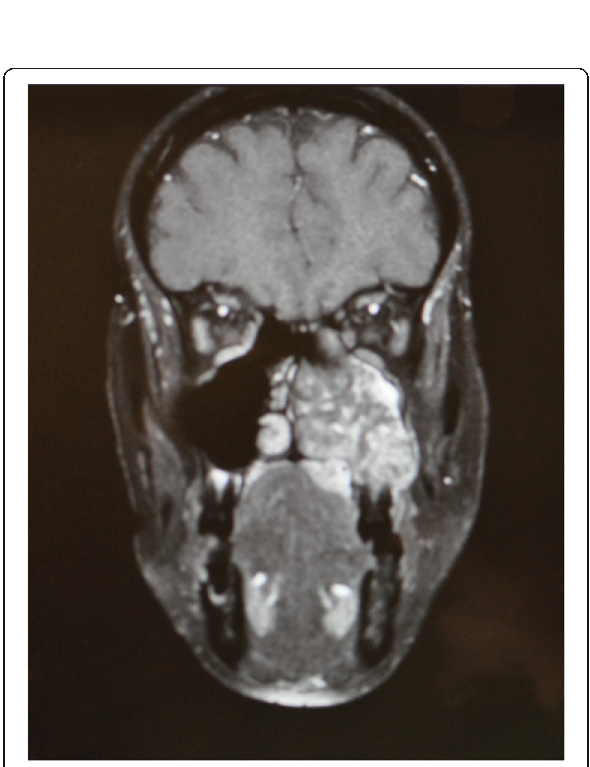
Fig. 7 Pt no. 2. Coronal plane of the preoperative CT scan showing a radiopaque mass of the left maxilla